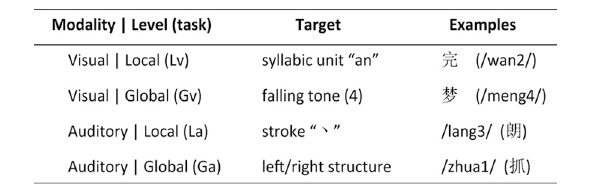
FIGURE 1 | Experimental design. Chinese pronunciations (pinyin) for visual-based tasks and Chinese characters for auditory-based tasks are displayed in